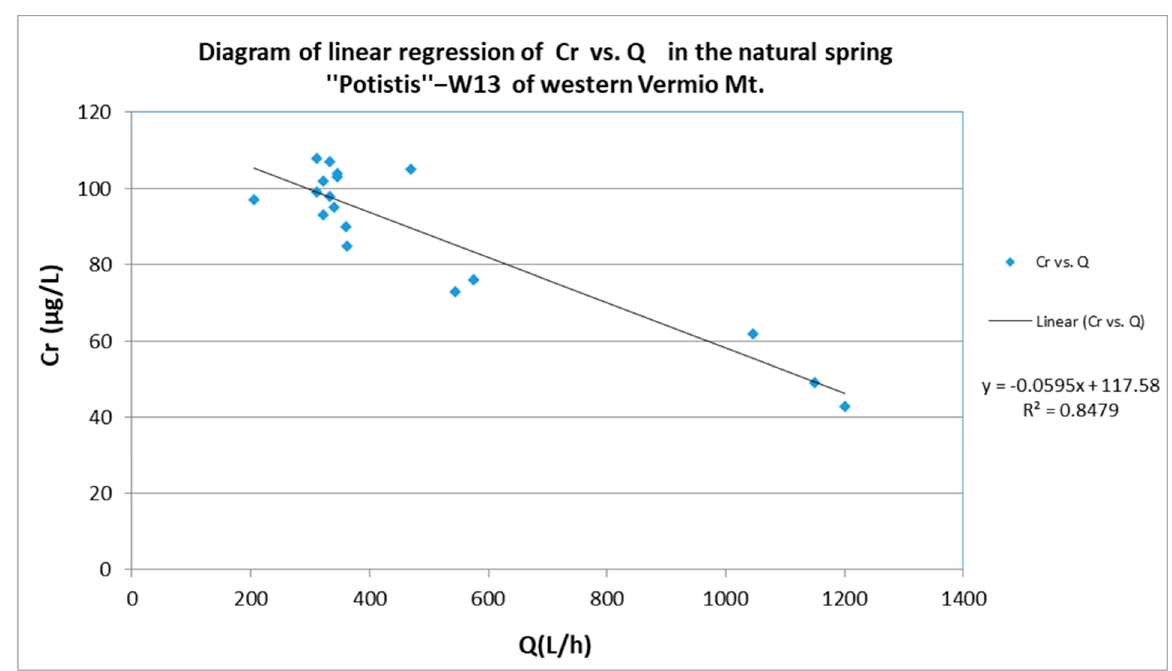
Figure 16. Fluctuation diagrams of rainfall and Cr concentrations of the natural spring ’’Potistis‘’ ‒ W13 in western Vermio Mt.